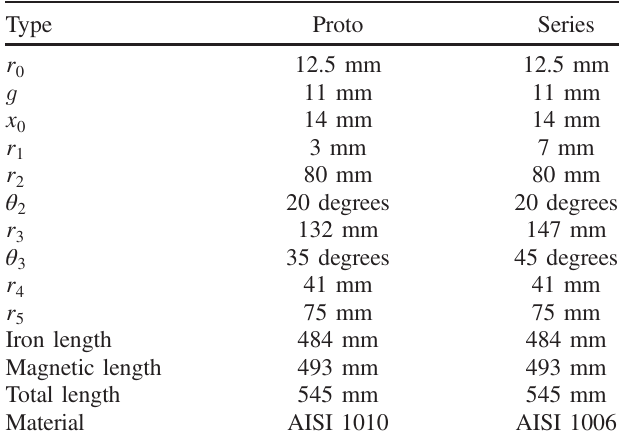
TABLE II. Design parameters of the high gradient quadrupoles. The prototype magnet has a tapered coil, while the series magnets will have a straight coil.